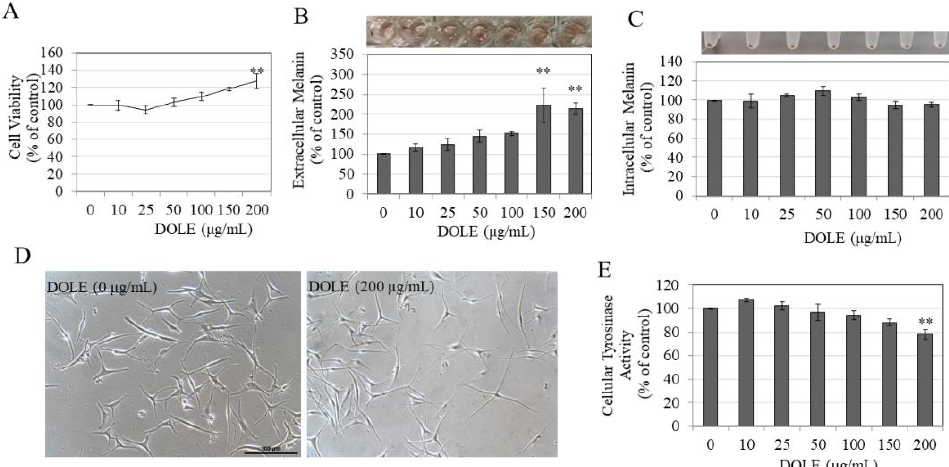
Figure 4. ( A ) HEMn-MP cell viability in the presence of different concentrations of DOLE for a duration of 48 h; ( B ) extracellular melanin and ( C ) intracellular melanin levels in cultures of HEMn-MP treated for 48 h with different concentrations of DOLE; ( D ) representative phase-contrast micrographs showing cells of control and cells treated without and with DOLE (200 µg/mL); ** p < 0.01 vs. control; one-way ANOVA with Dunnett’s post hoc test. ( E ) Cellular tyrosinase activity in HEMn-MP cells after treatment with DOLE for 48 h. All data are mean ± SEM of three independent experiments.